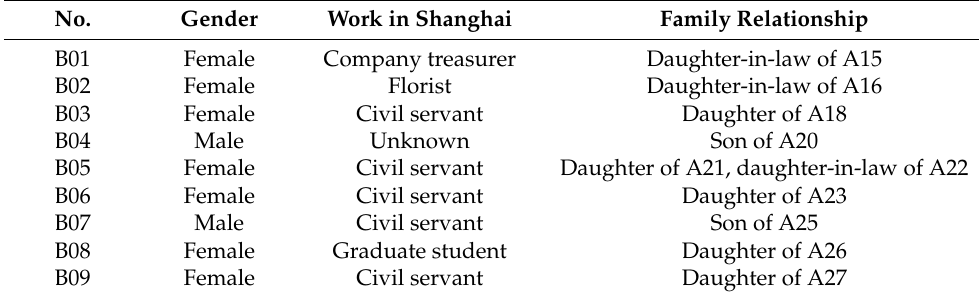
Table 3. Profile of the interviewed adult children (conducted in Stage